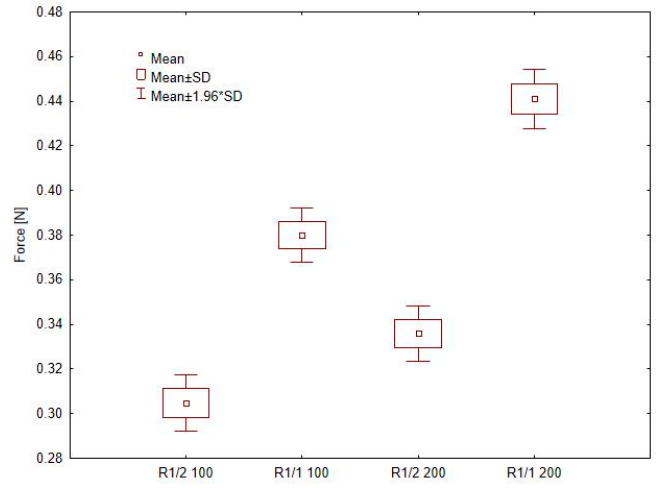
Figure 3. Box plot of summary statistics for conducted measures.